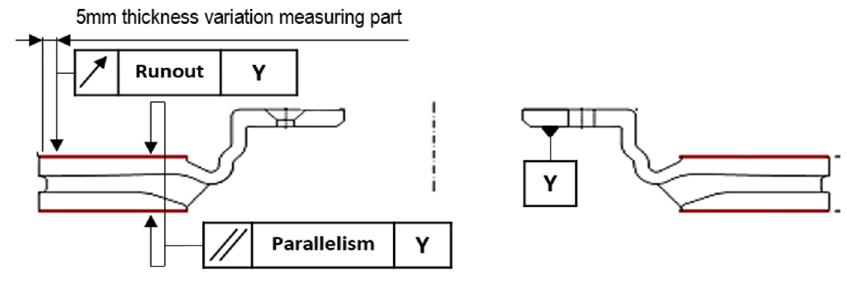
Figure 3. Three types of quality defect